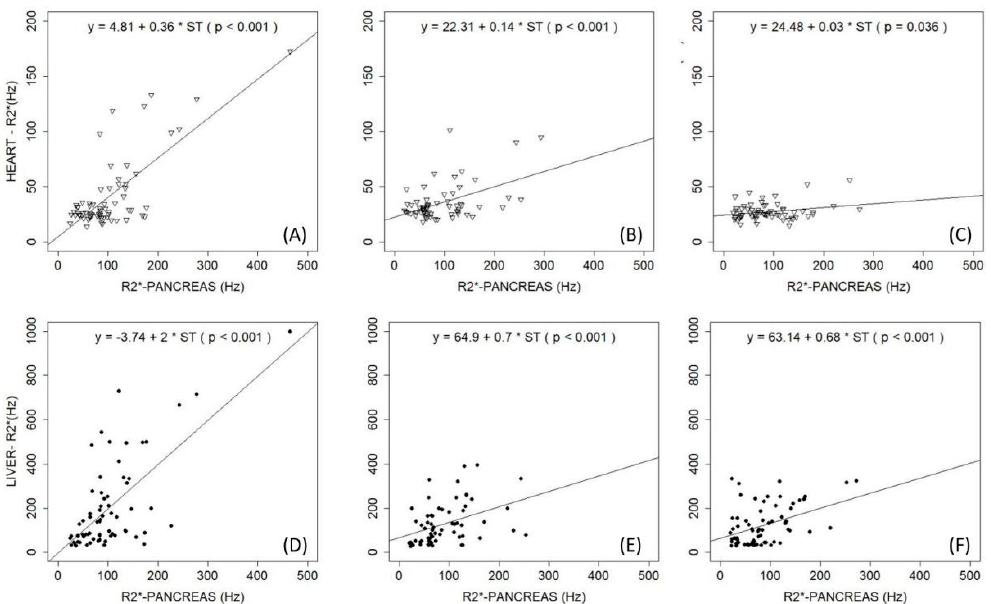
Figure 2. Observations at ( A , D ) baseline (time 0 years), ( B , E ) median value of 4 year follow-up, and ( C , F ) median value of 8 year follow-up. ( A – C ) Correlation of R2* values of pancreas and heart; ( D – F ) correlation of R2* values of pancreas and liver. With permission of Pinto et al. 2018 [62]. In Case 2, renal involvement was observed; factors implicated in renal damage that are specific to thalassemia are anemia, IOL, and iron chelators [25].